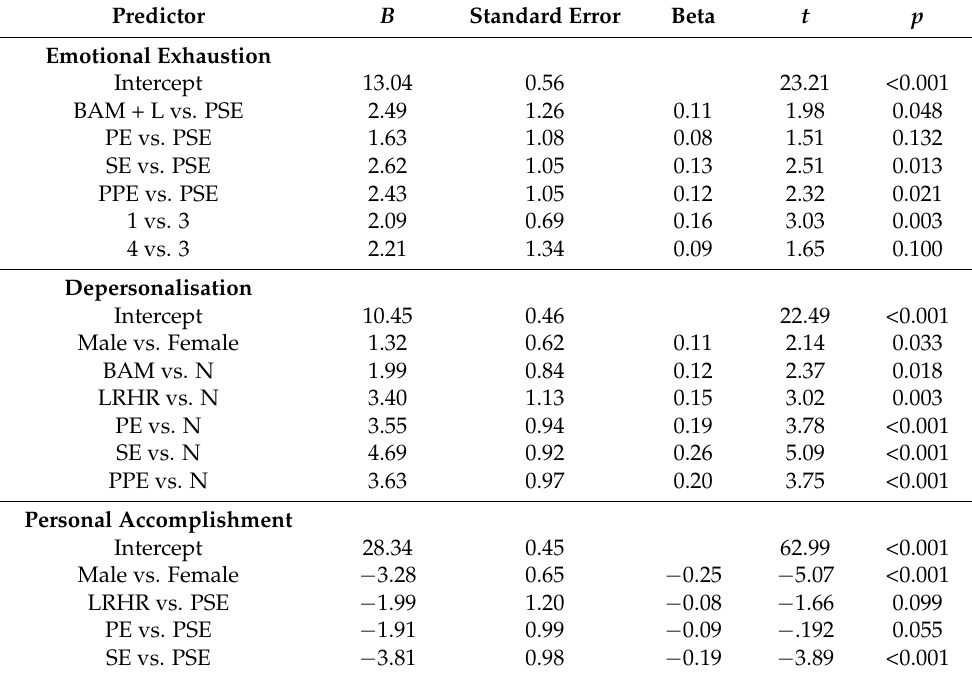
Table 3. Summary of the multiple linear regression model for Emotional Exhaustion, Depersonalisation and Personal